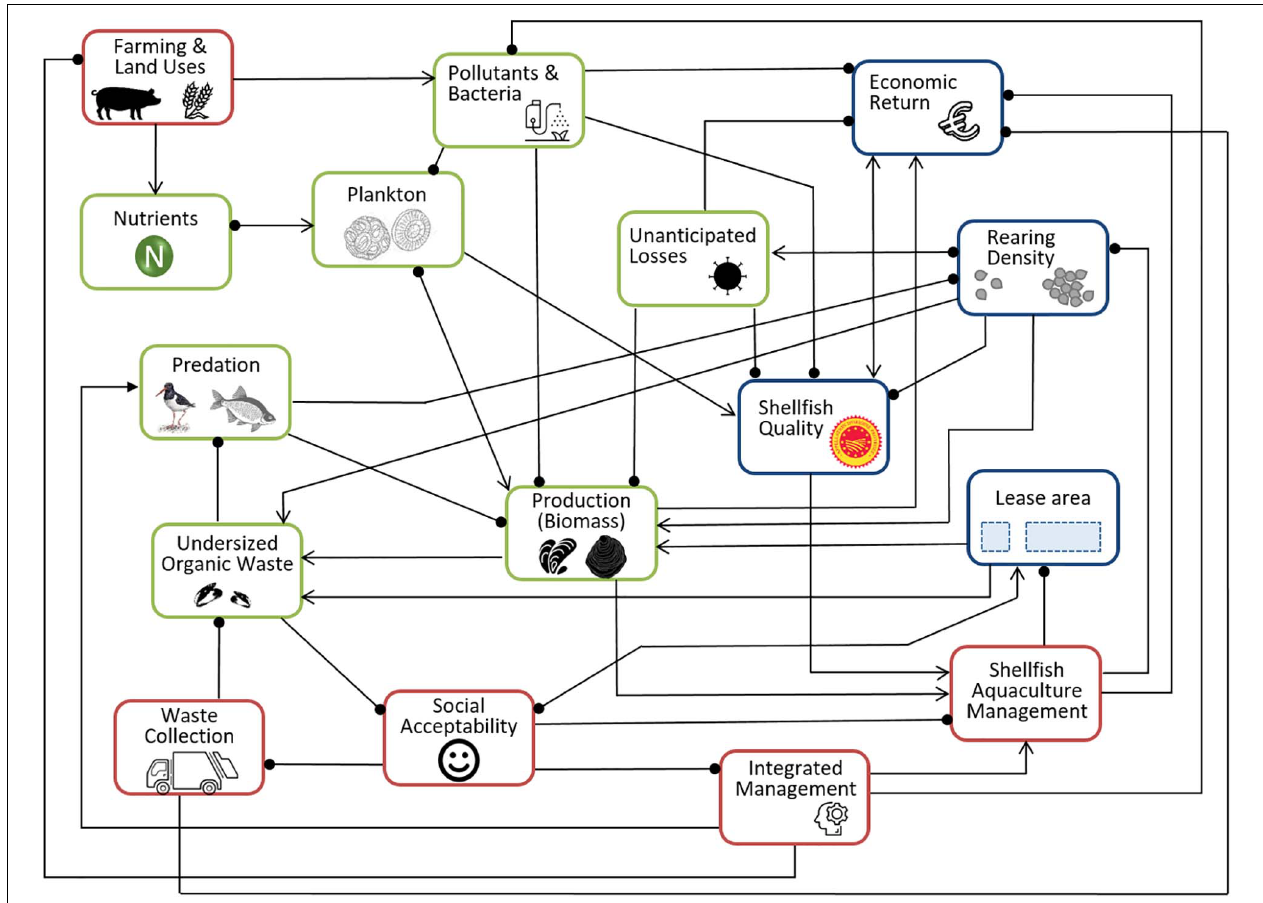
FIGURE 4 | Synthetic sign-directed graph of the NBG socio-ecological system, with environmental variables in green; economic variables in blue and social variables in red. indicates positive interaction, indicates negative